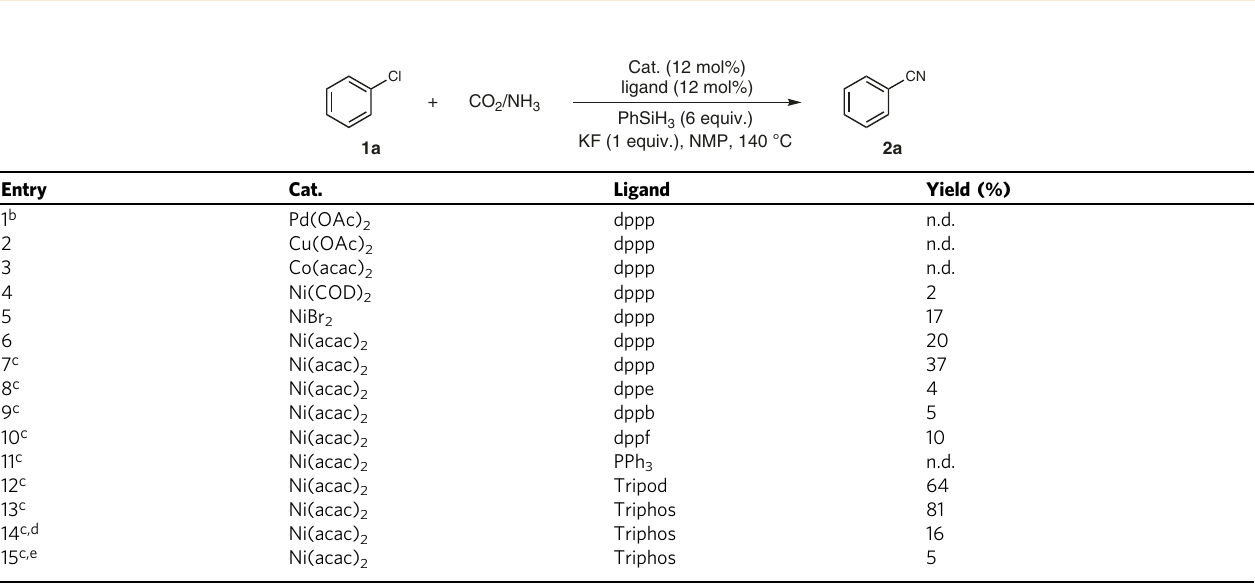
Table 1 Optimization of the reaction conditions a